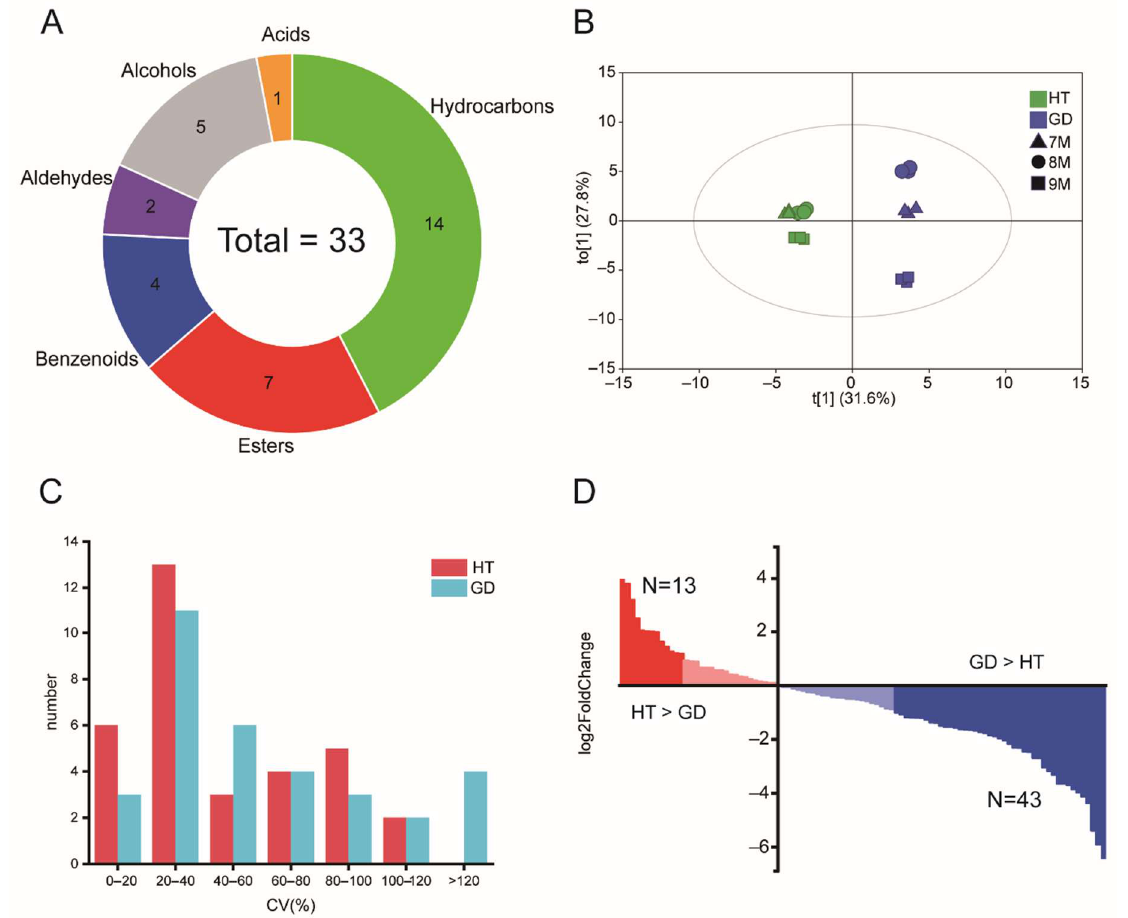
Figure 1. Statistical analysis of volatiles. ( A ) Metabolite classes of the volatiles detected in HS- SPME/GCMS analysis. ( B ) OPLS-DA scores plot analysis of detected volatiles between different varieties of coconut over three growth stages. ( C ) Coefficient of variation (CV) analysis redundant of the metabolome during flesh growth of HT and GD. ( D ) The distribution of the fold change between HT and GD. The metabolites are ordered based on their fold change between HT and GD.